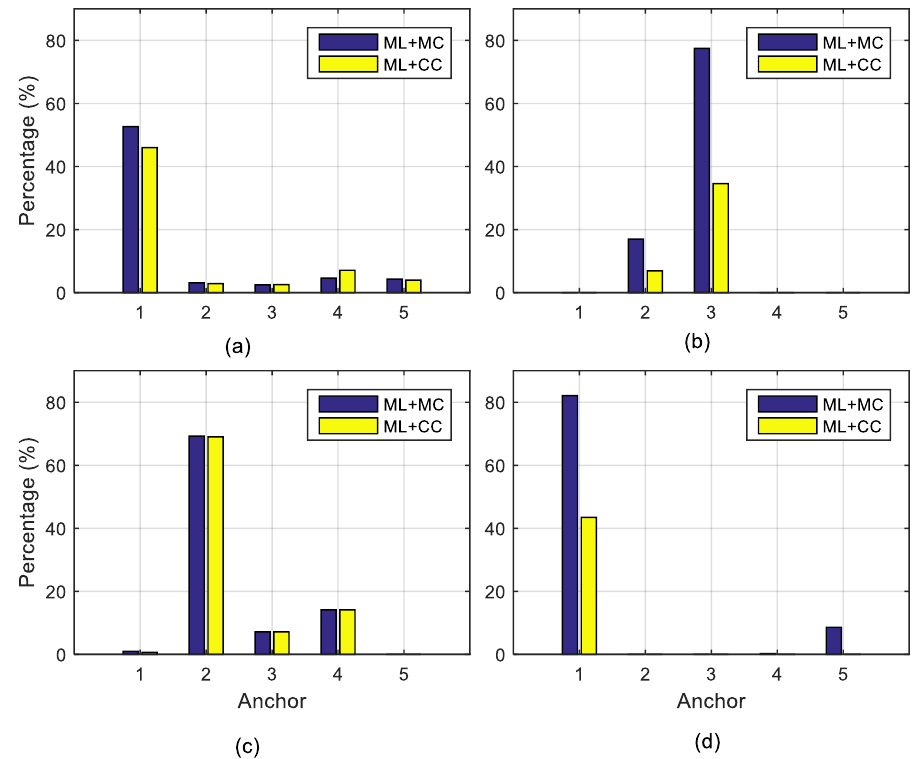
Figure 18. The distribution of identified NLOS by the consistency check algorithm. (a):MS 1 (b):MS 2 ( c ) MS 3; ( d ) MS (c):MS 3 (d):MS 4.